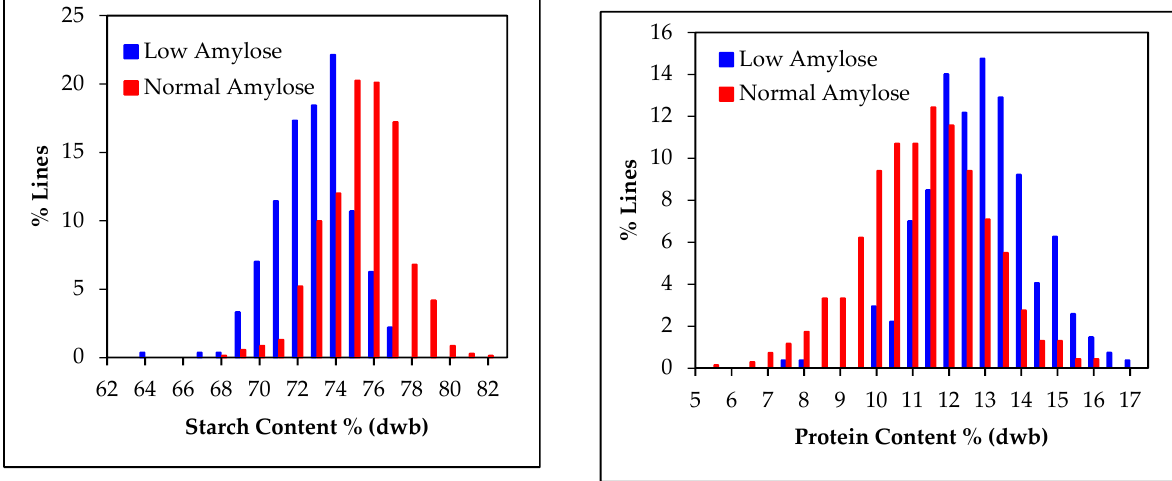
Figure 9. Variability of NIR predicted dry weight basis starch and protein contents in the low amylose (Amylose < 5%) and normal amylose (Amylose > 15%) grain samples of the two breeding